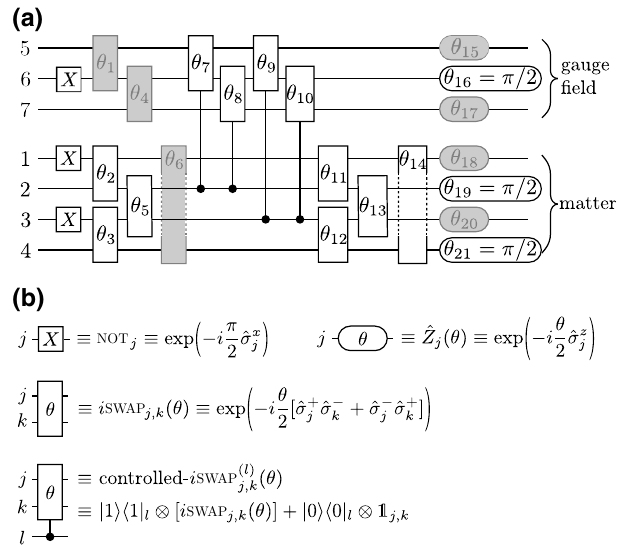
FIG. 4. The VQE circuit for preparing the ground state of a plaquette with open boundary conditions. (a) The quantum cir- cuit, with variational parameters θ l shown for each gate. By identifying symmetries and redundancies via classical simula- tion, the gates shaded in gray can be eliminated and we set = θ = θ = π/ 2, leaving 11 variational parameters. (b) θ 16 19 21 The definitions of the gates